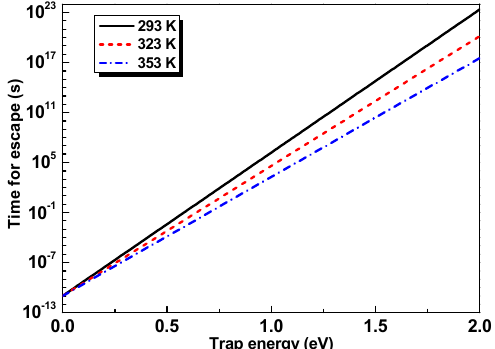
Figure 9. Time for an electron to escape from a trap with different energies at different temperatures.